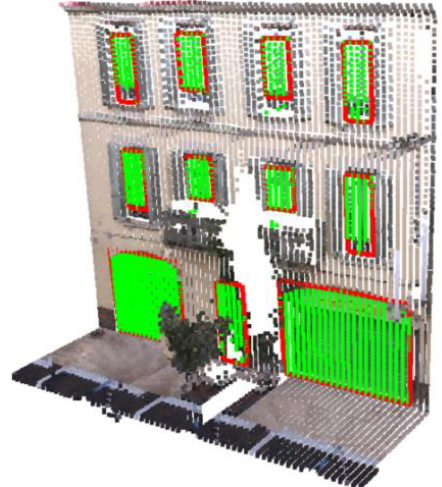
Figure 7: Tree and balcony partially occlude the wall but don't cause false